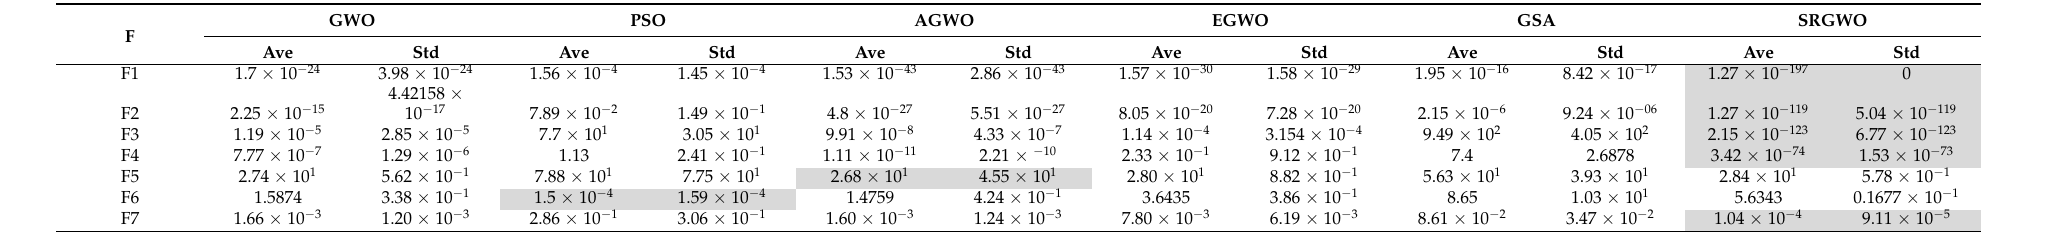
Table 1. Simulation results of uni-modal functions.